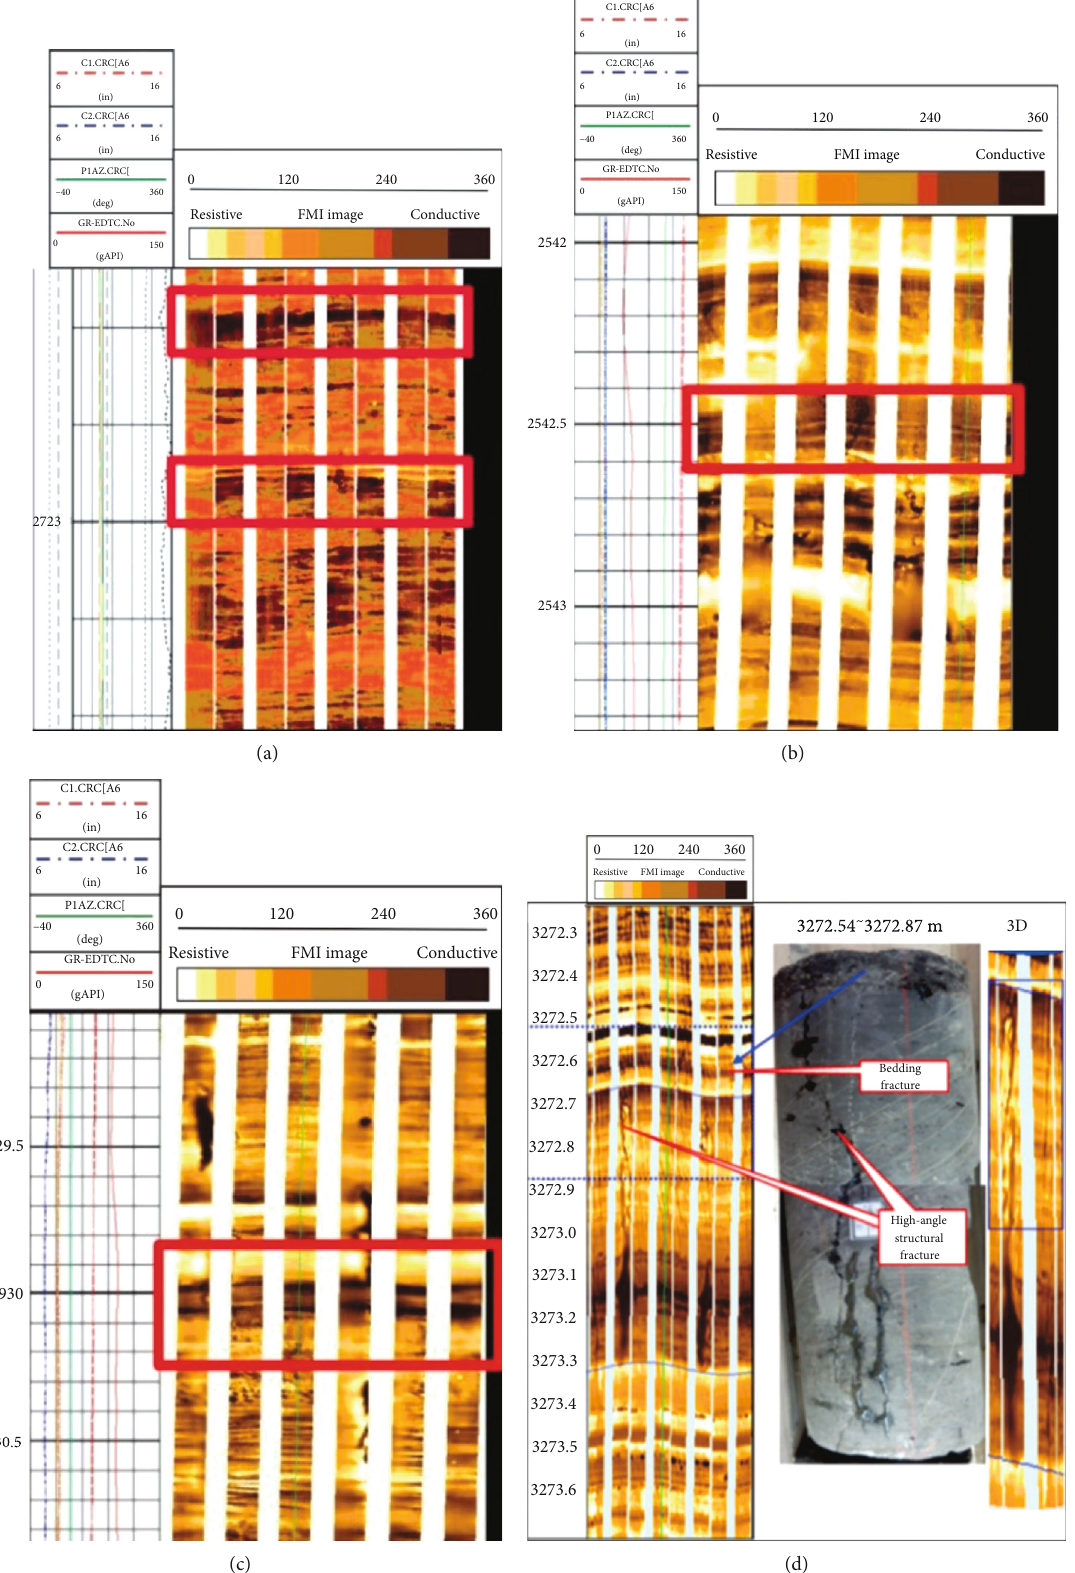
Figure 5: Imaging log identi fi cation diagrams of bedding fractures in Lucaogou formation in Jimsar sag. (a) Ji31, 2722.9m; (b) Ji22, 2542.8m; (c) Ji172, 2930m. Note: (d) Ji174, 3272.54 – 3272.87m, carbonaceous